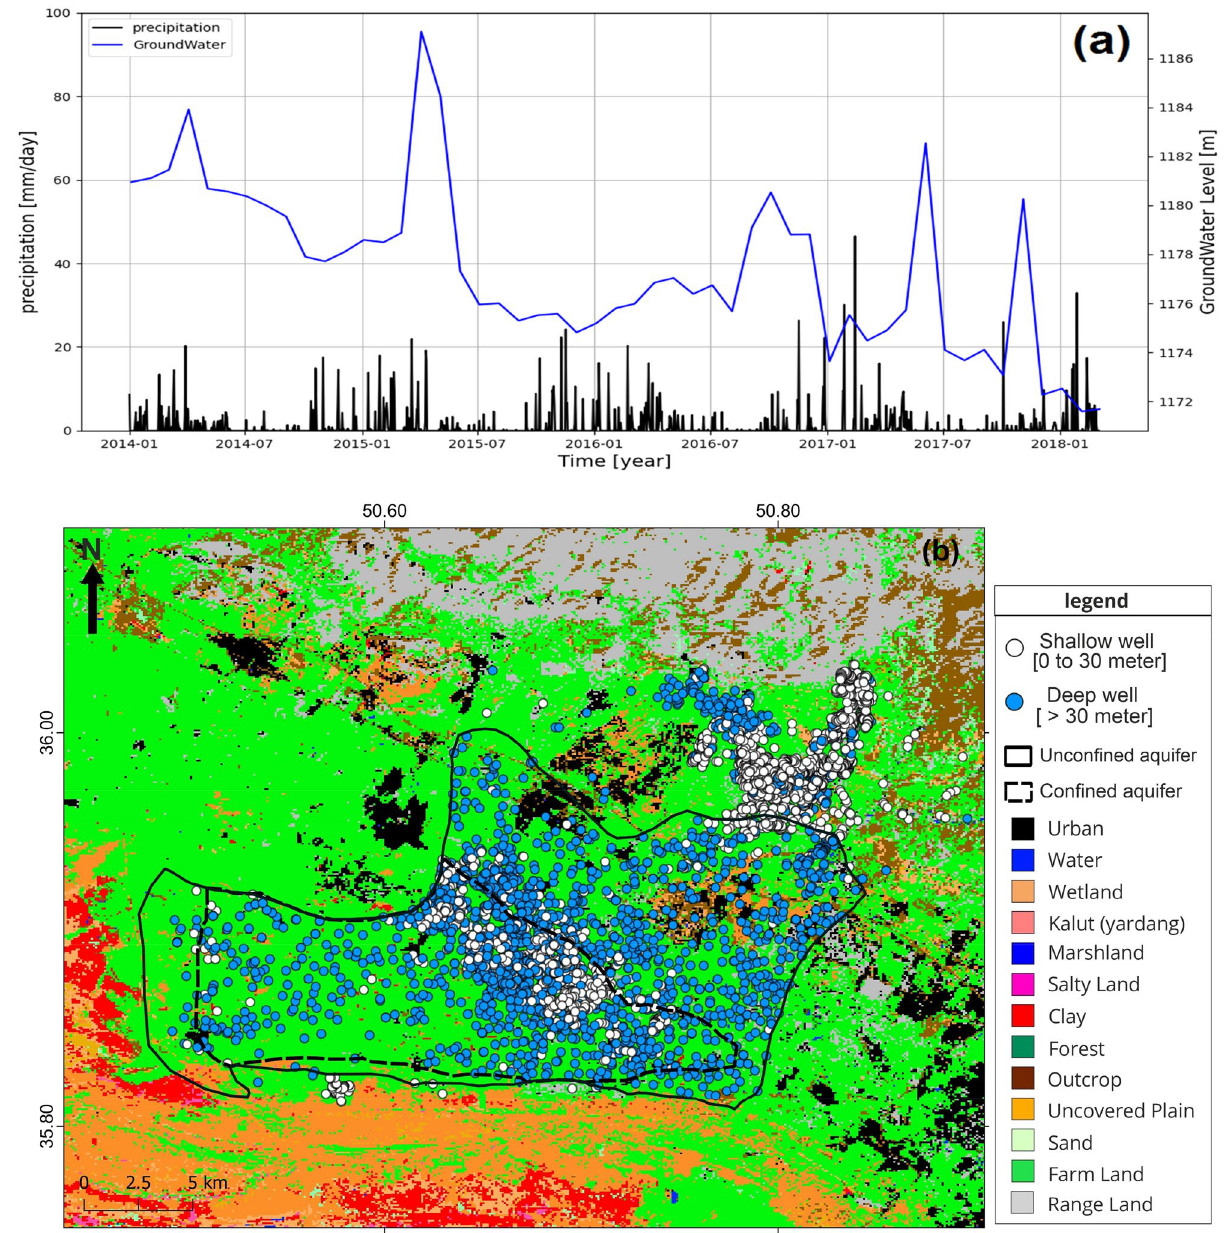
Figure 7. ( a ) Hydrograph derived from average total water level in piezometers and average daily rainfall using CHIRPS dataset in GEE between 2014 and 2018 for Hashtgerd catchment, and ( b ) land use map yielded by GEE and location and distribution of deep and shallow wells. This figure was created using the QGIS version Desktop 3.18.1 software (https:// qgis. org/ en/ fine clay and silt sediments become more dominant as we move to the center and west of the plain (Fig. 9a,b). Furthermore, the presence of fine sediment layers in the upper parts of the aquifer has cut the hydrologic con- nection between the aquifer and the ground surface. The only source of recharge for the semi-confined aquifer is the Kordan River, whose flow has decreased in recent decades, hence, has reduced aquifer recharge. The aquifer’s shrinking water level has increased the effective stress and compaction of fine sediments in this area, which is completely consistent with the subsidence pattern. The water level of piezometers (Fig. 8) shows that the majority of groundwater abstraction has occurred on the unconfined aquifers of alluvial fans in the northern and eastern parts. However, the subsidence rate in these areas is lower in the central areas, and in most cases, is close to zero. Piezometers on alluvial fan unconfined aquifers, such as wells #9 and #15, show no correlation between groundwater level and subsidence. In addition, Piezometer #17 revealed a 0.86 correlation between groundwater depletion and subsidence. The log profile AA’ (Fig. 9a), which is located near piezometers #15, #9, and #21, demonstrates that coarse sediments have been deposited